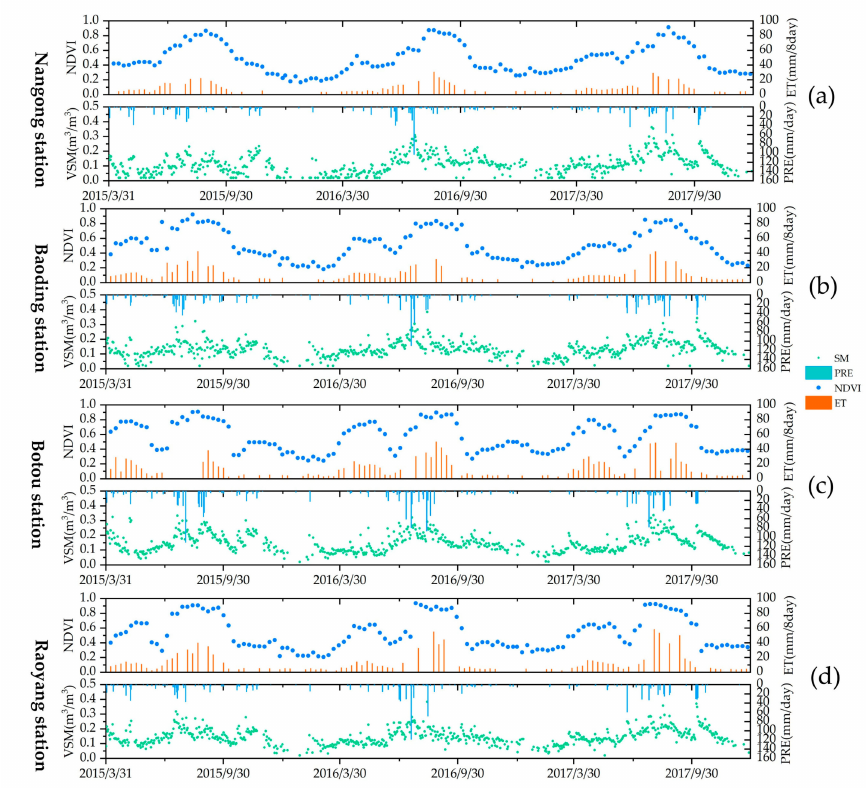
Figure 5. NDVI (8-day maximum synthesis), ET (8-day), precipitation (daily) and SM (daily) time series variations. ( a ) Nangong, ( b ) Baoding, ( c ) Botou and ( d ) Raoyang meteorological stations; and VSM means volume of soil moisture. The land cover at Nangong and Baoding stations was rainfed crops, and the land cover at Botou and Raoyang was winter